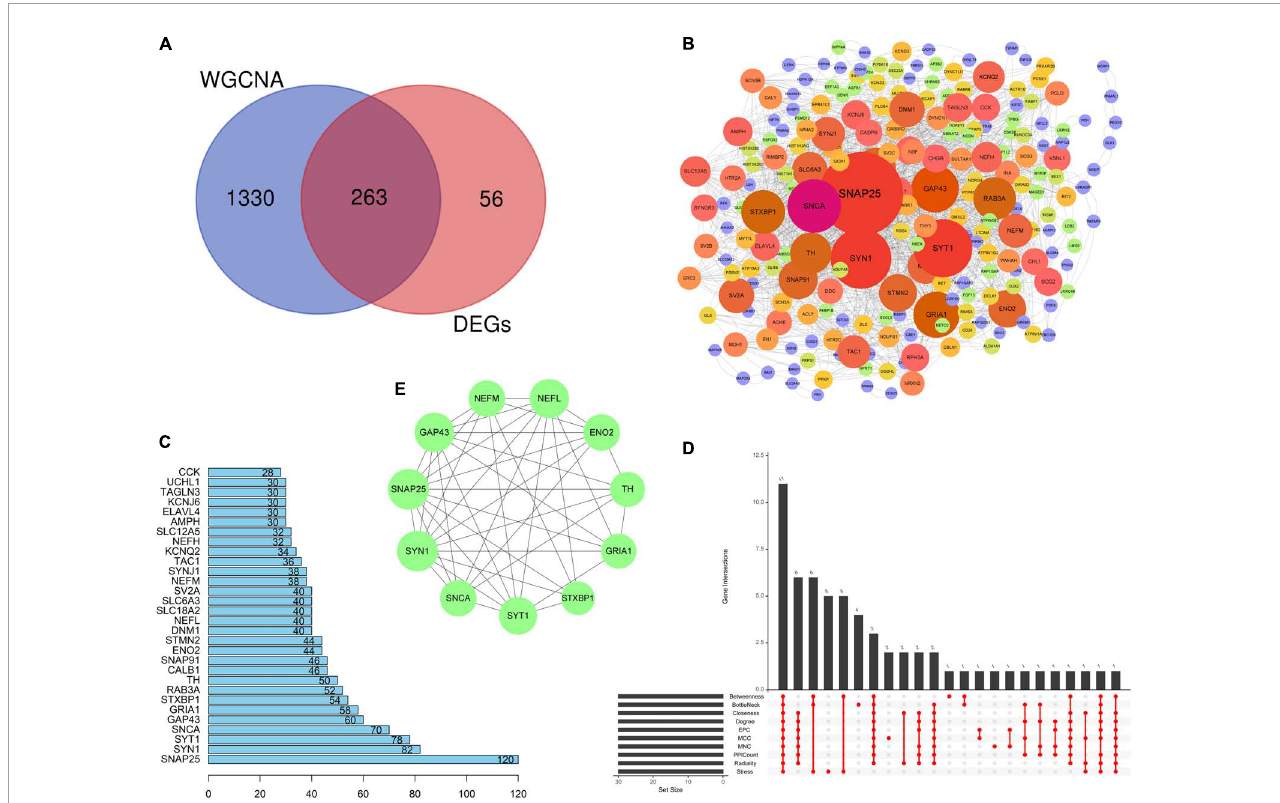
FIGURE5 Protein–protein interaction network and identification of candidate hub genes. (A) Venn plot showing the intersection between the DEGs and genes in the turquoise module, and 263 CGs were obtained. (B) PPI network of CMs by Cytoscape. The size and gradient color of circles are adjusted by the degree value, which reflects the connectivity between nodes. The size of circles has a positive correlation with the degree value. (C) PPI Count, revealing the number of adjacent nodes of the top 30 genes (ranked from low to high) based on the PPI network. (D) UpSet plot showing the intersection of ten algorithms, namely, MCC (top 30), MNC (top 30), Degree (top 30), EPC (top 30), BottleNeck (top 30), Closeness (top 30), Radiality (top 30), Stress (top 30), and Betweenness (top 30), and PPI Count (top 30). (E) Eleven candidate hub genes. All these candidate hub genes were found to be downregulated. PPI, protein–protein interaction; CGs, common genes; MCC, maximal clique centrality; MNC, maximum neighborhood component; EPC, edge percolated component.